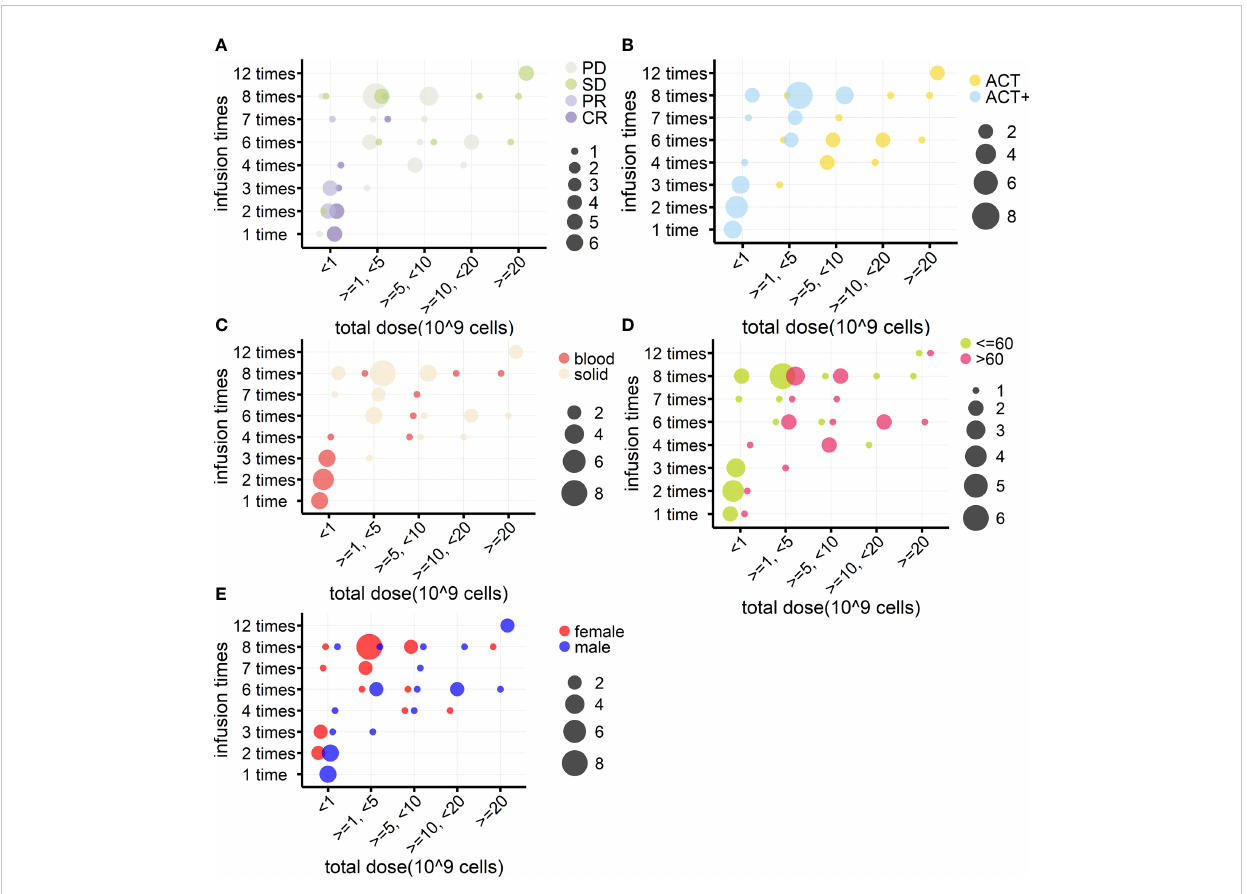
FIGURE 5 Relationships between gd T cell reinfusion doses and treatment outcome, strategy, tumor type, age, and sex ( n = 46). (A) Relationship between treatment outcome and dosage. gd T-cell total infusion cell numbers (10 (9) cells) were divided into fi ve groups and are presented on the x -axis; the y -axis indicates total infusion times. The bubble color indicates the treatment outcome, and the bubble size indicates the number of patients. (B) Relationship between treatment strategy and dosage. (C) Relationship between tumor type and dosage. (D) Relationship between age and dosage. (E) Relationship between sex and